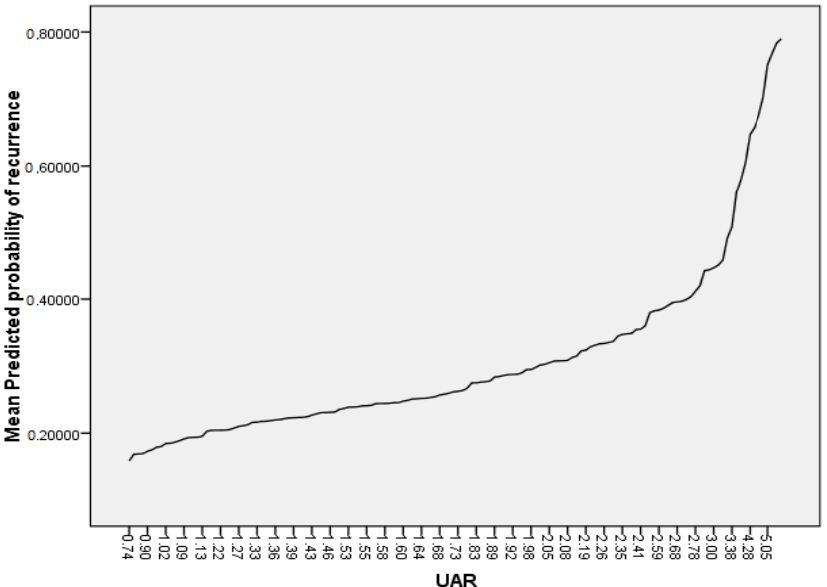
Figure 4. Relationship between probability of atrial fibrillation recurrence and uric acid/albumin ratio (UAR).